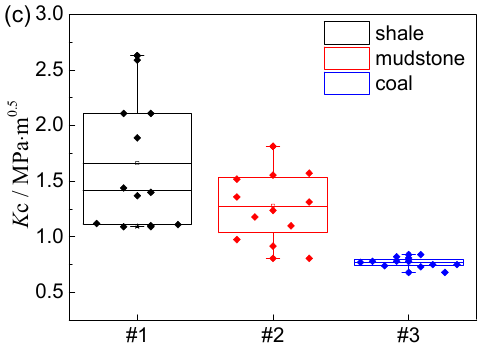
Figure 11. Statistical analyses of ( a ) hardness, ( b ) elastic modulus and ( c ) fracture toughness.